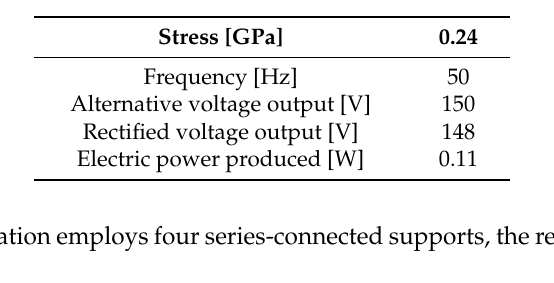
Table 13. Summary of the results concerning a single support.